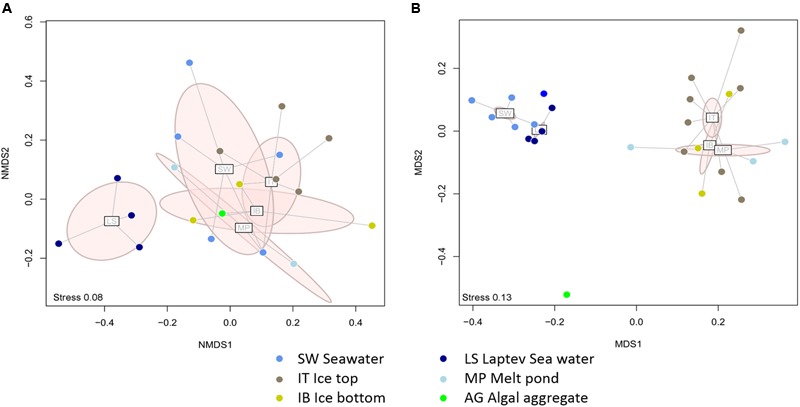
Dissimilarities between the diazotrophic communities (A) and the entire bacterial communities (B) of different Central Arctic environments. Laptev Sea (LS) samples are in dark blue, Ice Top (IT) in brown, Ice bottom (IB) in yellow, Surface waters (SW) in blue, Melt Ponds (MP) in light blue, and ice algal aggregate in green. Points within each group are connected to their group centroid with a spider diagram. The light pink ellipses show 95% dispersion of each group. (A) Two dimensional NMDS ordination plot of Jaccard dissimilarities based on the presence absence of nifH subclusters in each sample. The stress of the plot is 0.08. An ANOSIM post hoc test showed that the Laptev Sea samples are significantly different from the sea-ice environment samples (R = 0.46, p = 0.003). Individual p values were Bonferroni corrected. (B) Two dimensional NMDS ordination plot of Bray-Curtis dissimilarities based on the relative abundances of ARISA OTUs. The stress of the plot is 0.13. An ANOSIM post hoc test showed strong dissimilarities between the Surface Water and the Ice Top samples (R = 0.94, p = 0.005) as well as the Laptev Sea and Ice Top samples (R = 0.90, p = 0.014). Individual p-values were Bonferroni corrected.